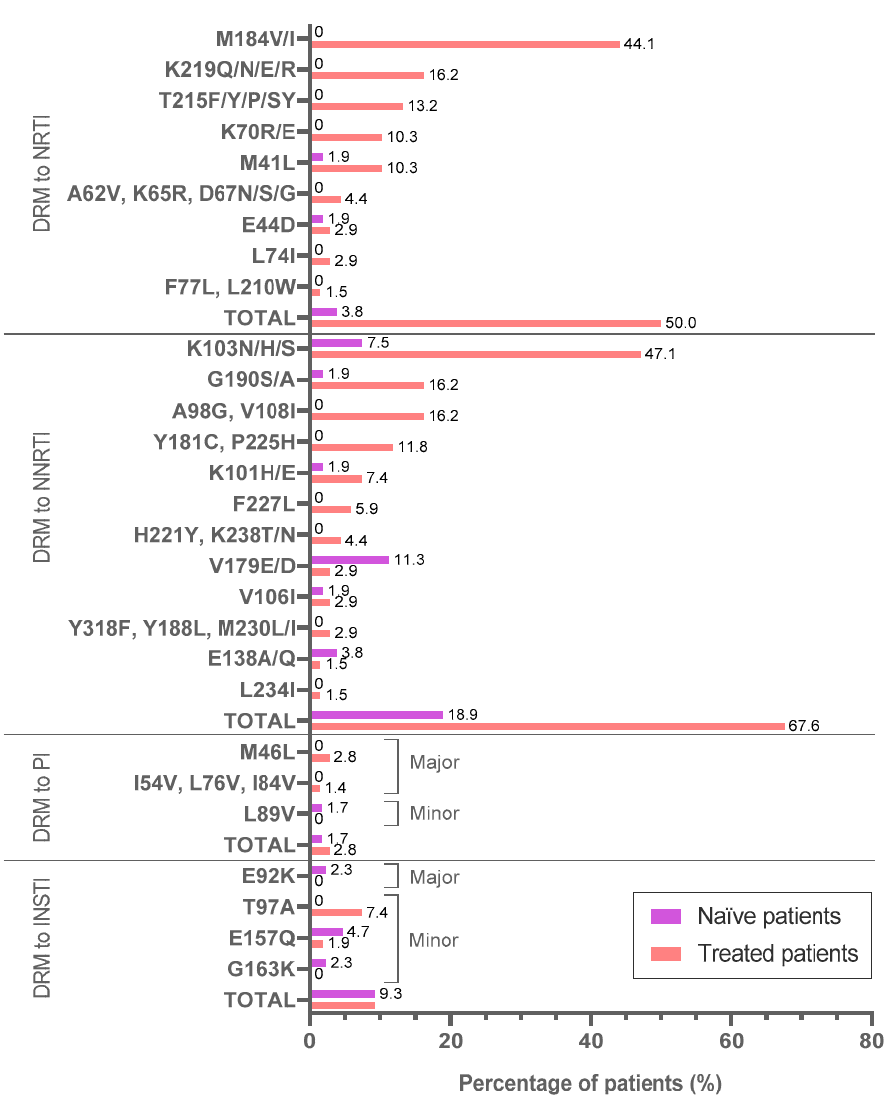
Figure 3. Drug resistance mutations to the main antiretroviral classes in the study cohort. Available sequences in 141 subjects under study: 131PR, 121RT and 97IN. DRM, drug resistance mutation; naïve, ART-naïve; treated, ART-treated; NRTI, nucleoside reverse transcriptase inhibitors; NNRTI, non-NRTI; PI, protease inhibitors; INSTI, integrase strand transfer inhibitors. We considered DRM to NRTI and NNRTI and major and minor-DRM to PI and INSTI, according to Stanford v9.0. DRM in the same line are equally prevalent. DRM to INSTI E92K is an APOBEC mutation identified as a major-DRM by Stanford. Percentages were calculated over the number of sequences available from each region. More data available in Table S3.